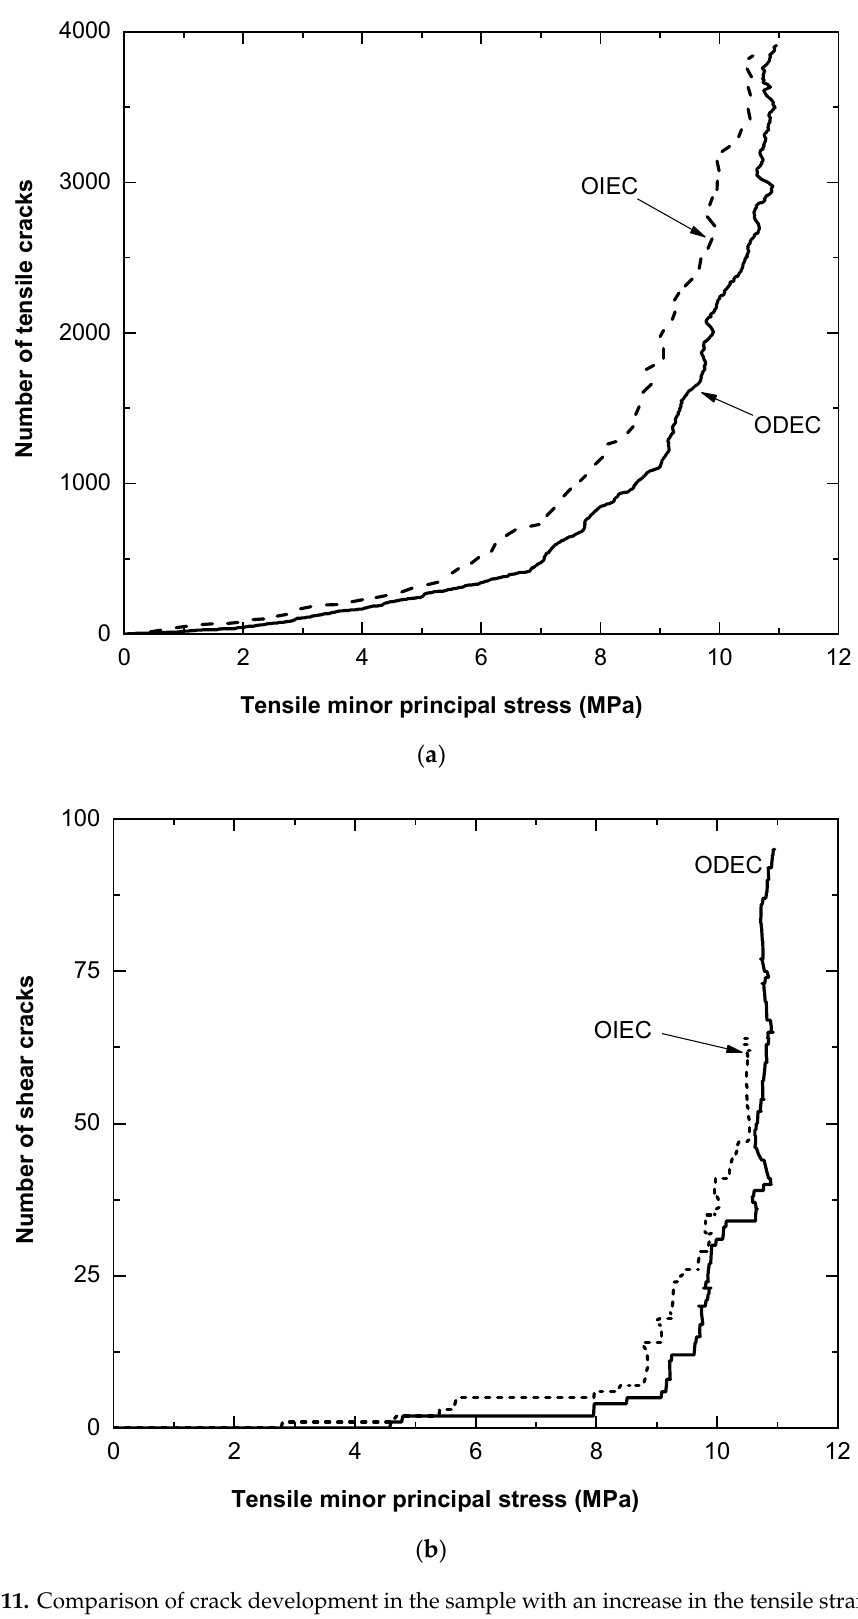
Figure 11. Comparison of crack development in the sample with an increase in the tensile strain from point E to point C for stress paths ODEC and OEC: ( a ) tensile cracks and ( b ) shear cracks.